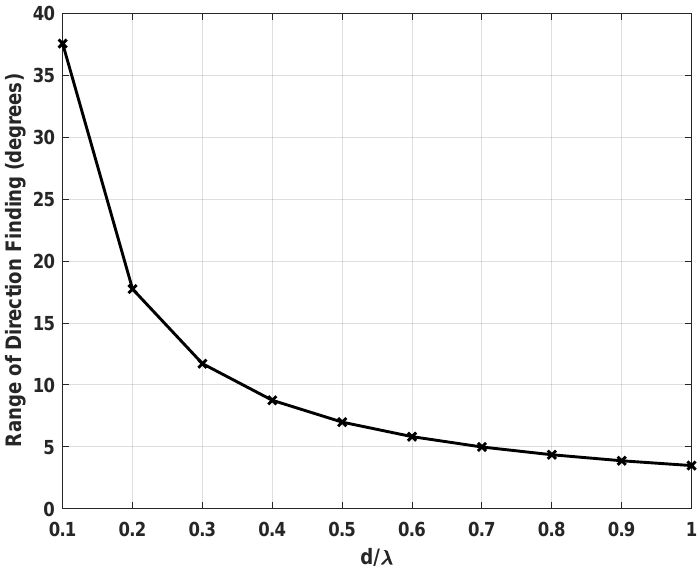
Figure 2. The relationship between the range of direction-finding and the length of